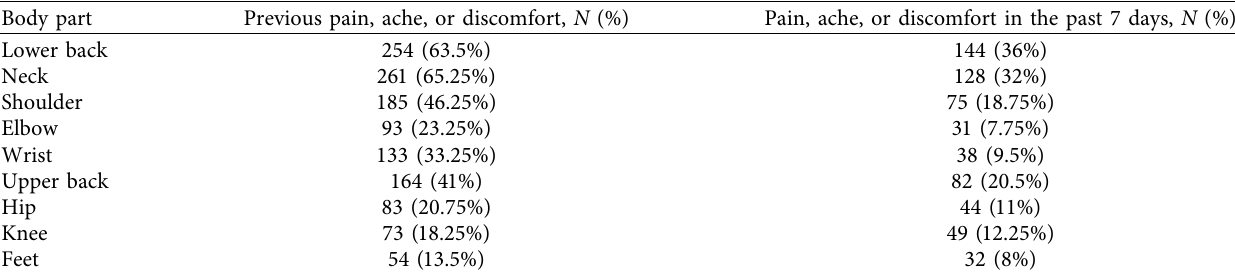
Figure 2: Dental specialties for which dental loupes were believed to be most useful. Table 5: Participant prevalence of musculoskeletal pain related to